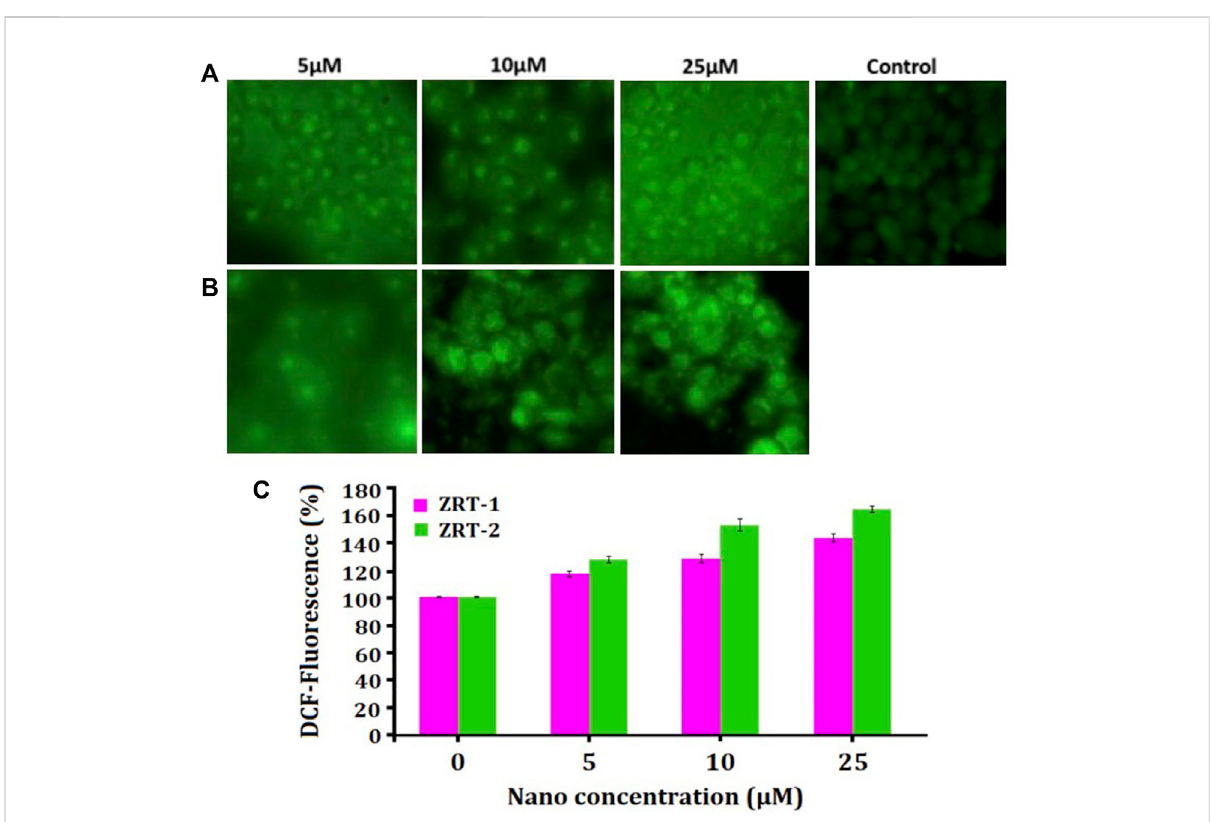
FIGURE 7 (A,B) : Photomicrographs showing intra-cellular ROS generation in human epidermoid carcinoma A431 cell lines induced by control, 5 μ M, 10 μ M, and 25 μ M concentration of zinc oxide nano-particles, ZRT-1 and ZRT-2, respectively after 12 h incubation and stained with DCFH-DA. (C) Graph showing extent of ROS generation expressed as the percentage of fl uorescence intensity relative to the control. Values are expressed as mean ± SEM of at least three independent experiments, * p < 0.05 as compared with their respective